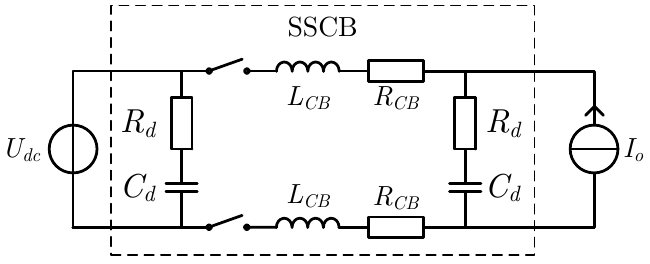
Figure 15. Circuit that is used to show the effect of the RC dampers on the commutation of an (inductive) current.